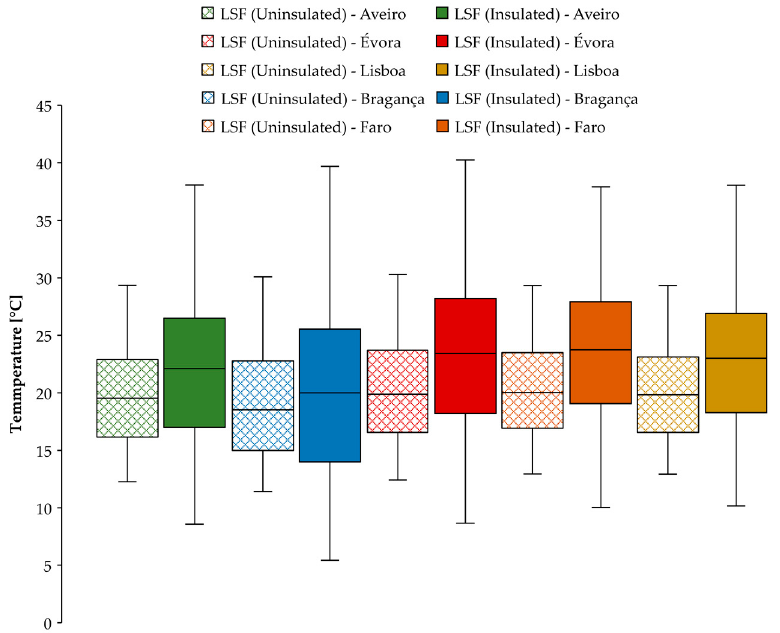
Figure 10. Annual box plot representation of the indoor temperature obtained from dynamic simulations: uninsulated vs. insulated ground slab.